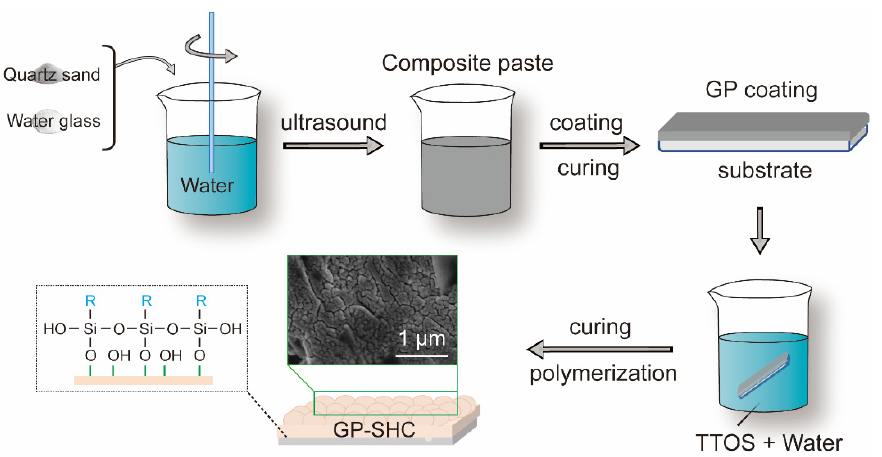
Figure 1. Schematic diagram of the preparation of GP-SHC.